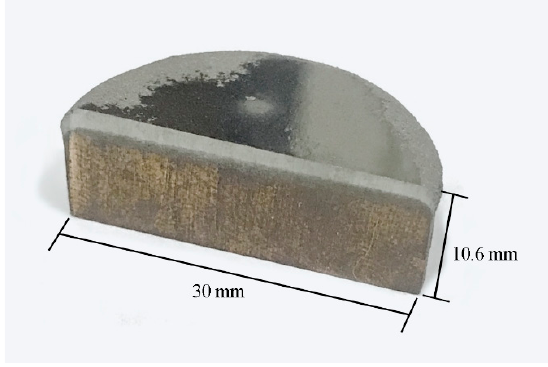
Figure 1. Cross-section of examined sample.